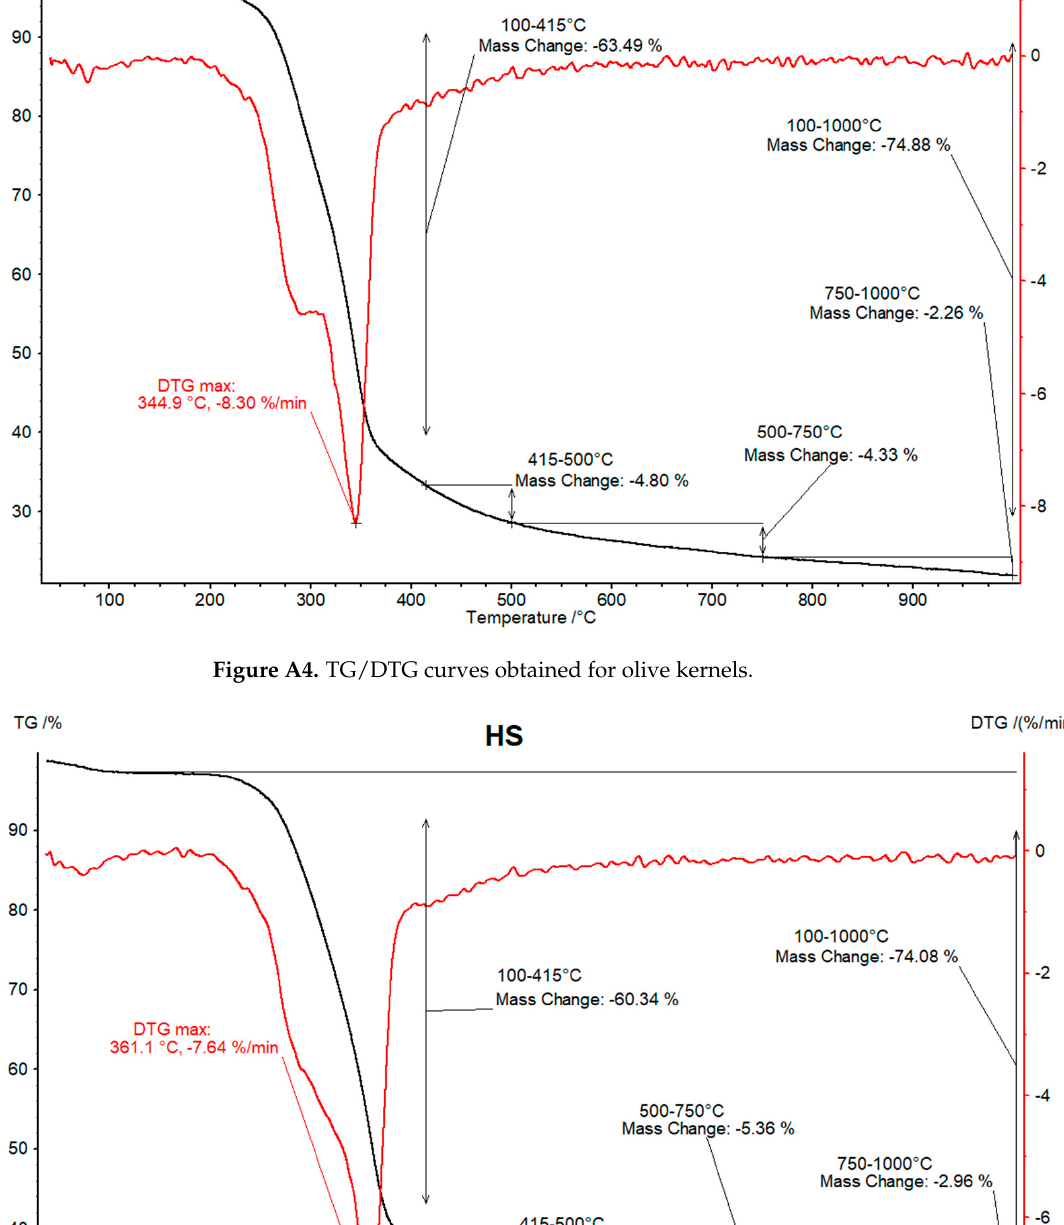
Figure A3. TG/DTG curves obtained for beech/alder chips.